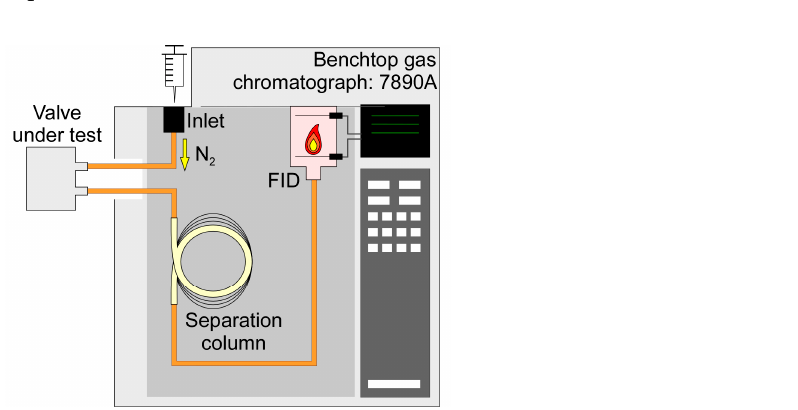
Figure 11. Cycling lifetime test of the microvalve. The sudden change of flow rate at t = 20 min. resulted from an imposed reversal of flow direction.